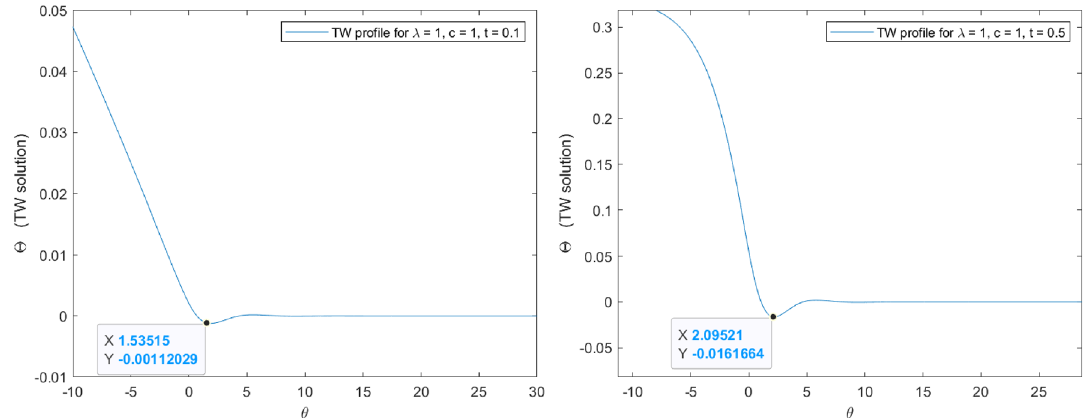
Figure 7. Exact travelling wave profiles for A = B = 1 . Note that the first minimum is negative and the profiles evolves oscillating.